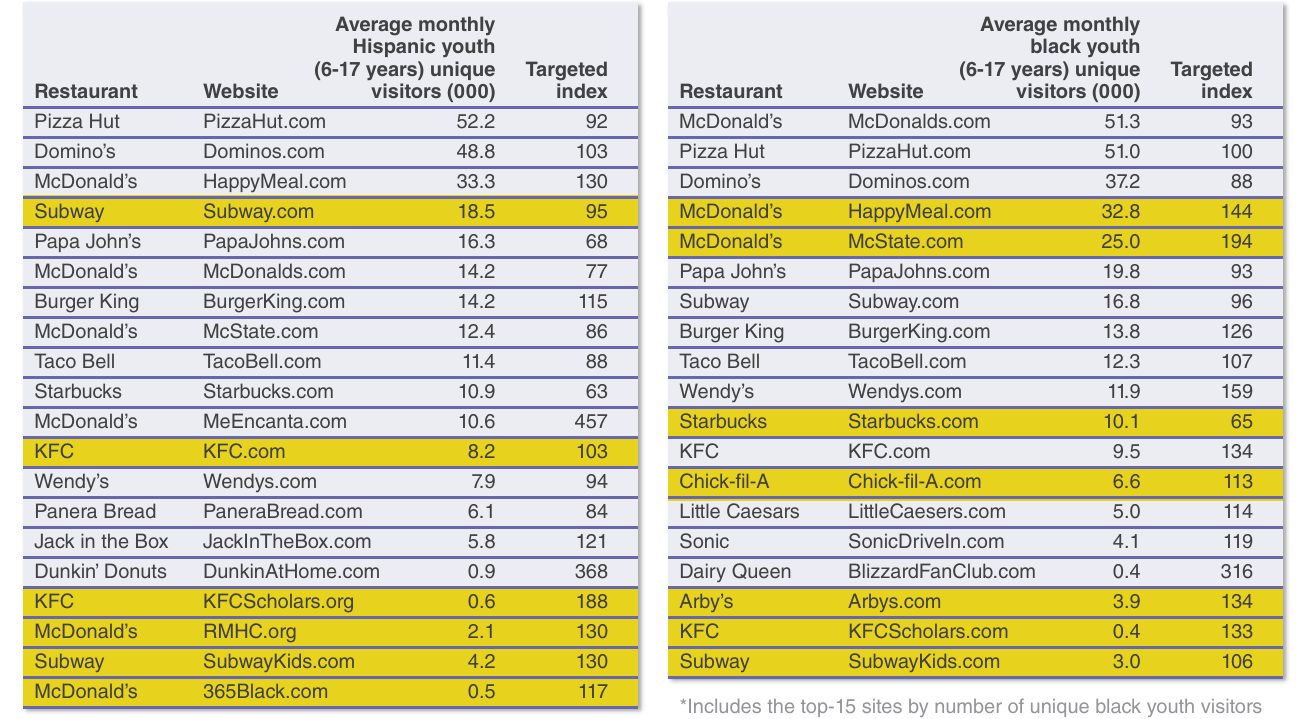
Table 45. Hispanic youth visitors to fast food websites Table 46. Black youth visitors to fast food